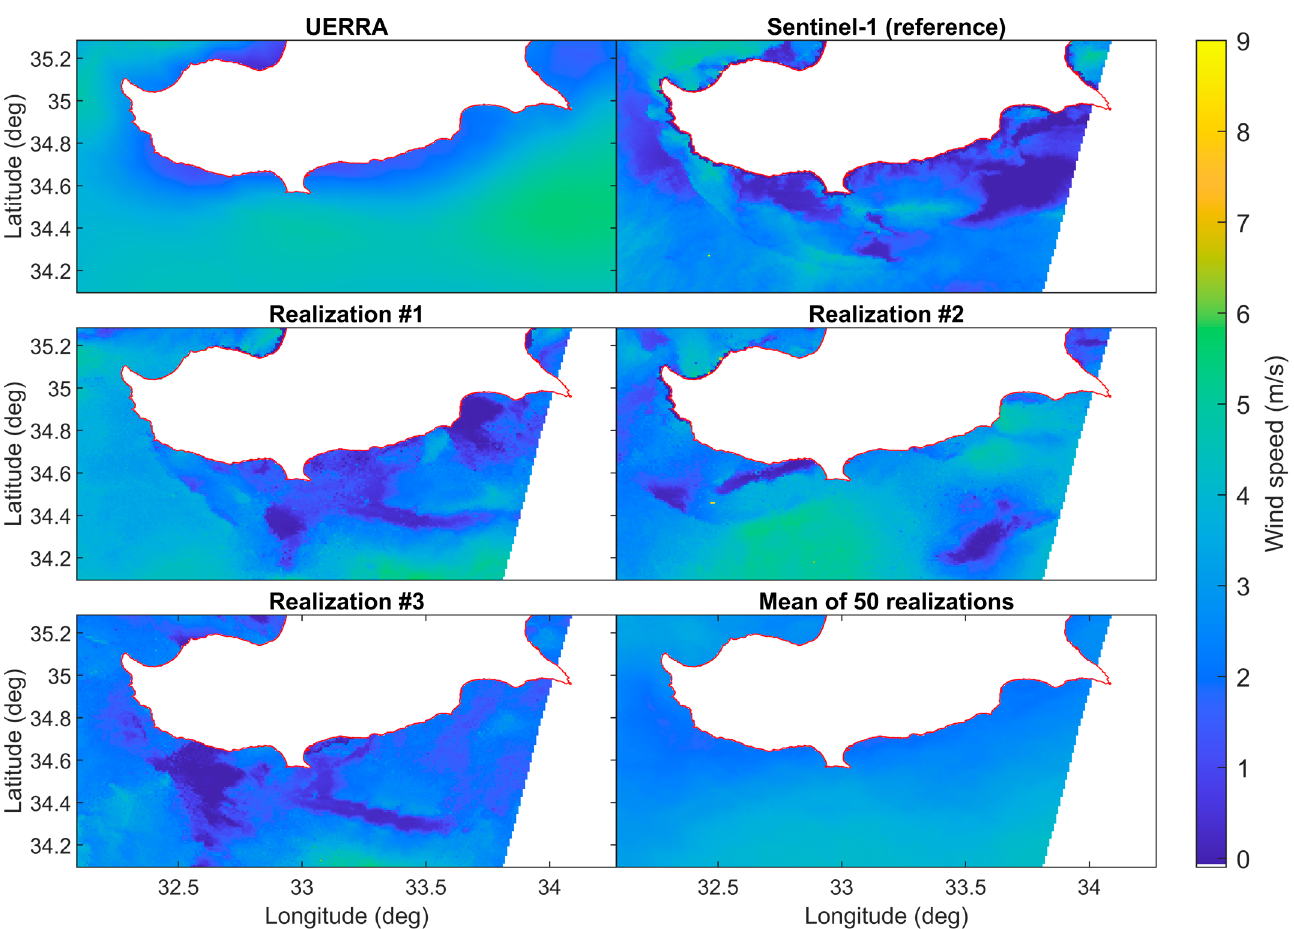
Figure 6. Visual comparison between wind speed (m ⁄ s) images from UERRA, Sentinel-1, 3 realiza- tions and the mean of 50 realizations on 15 June 2017.